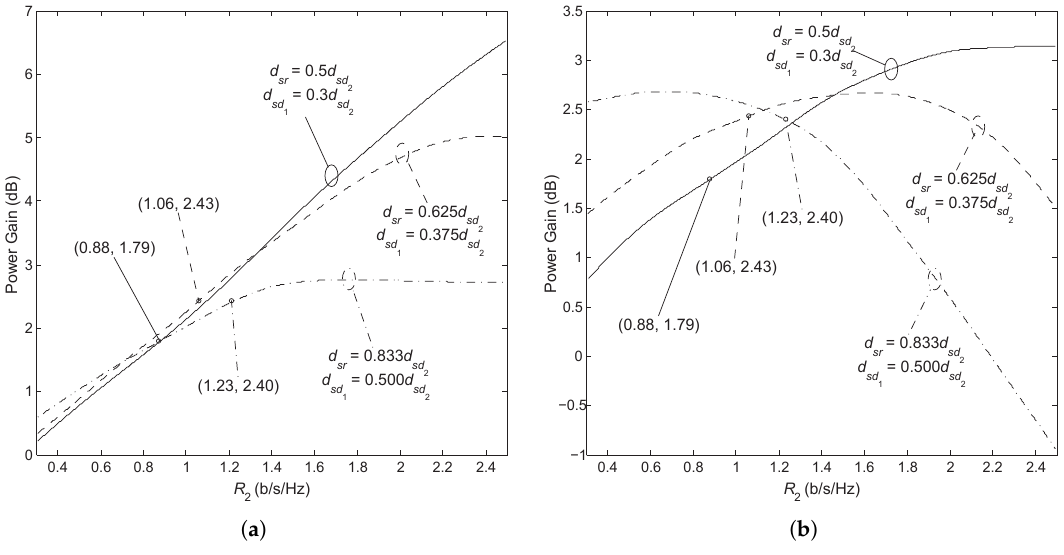
= P th = 0.01. The three out ,2 out ,1